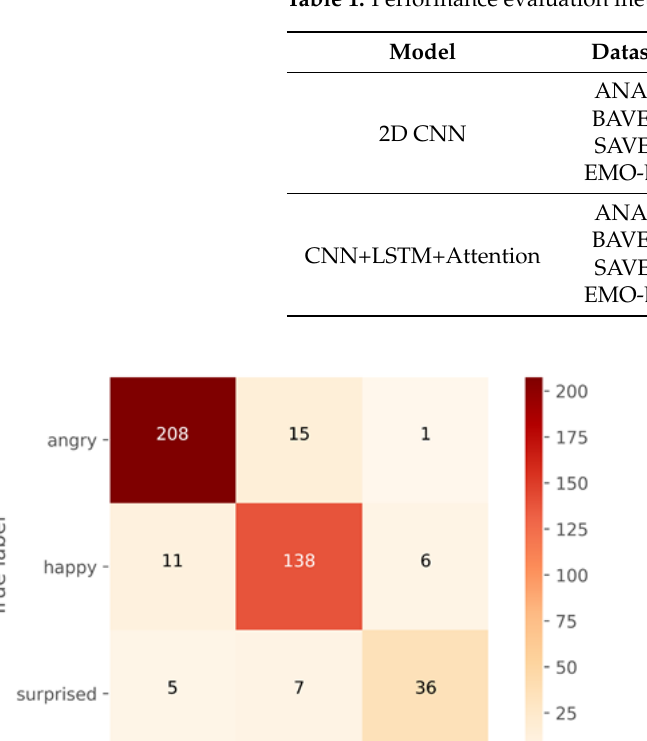
Table 1. Performance evaluation metrics.